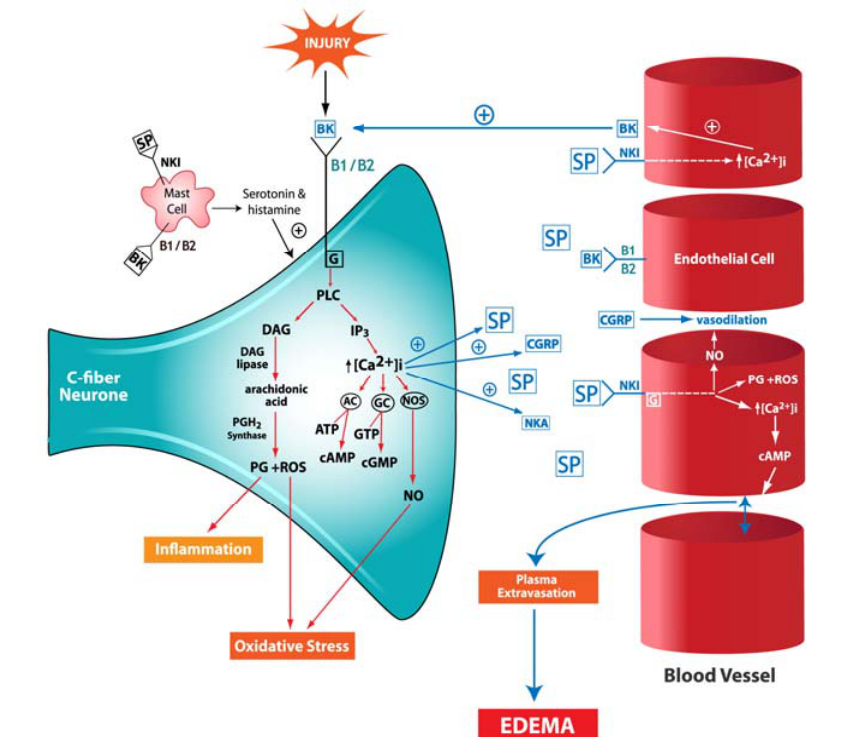
Figure 1. Schematic representation of kinin induced neurogenic inflammation in the central nervous